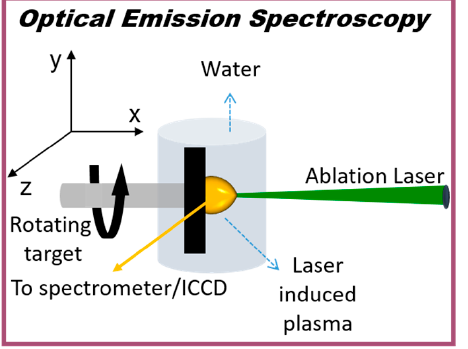
Figure 2. Sketch of the experimental set-up for optical emission spectroscopy (OES) of laser-induced plasma in liquid.